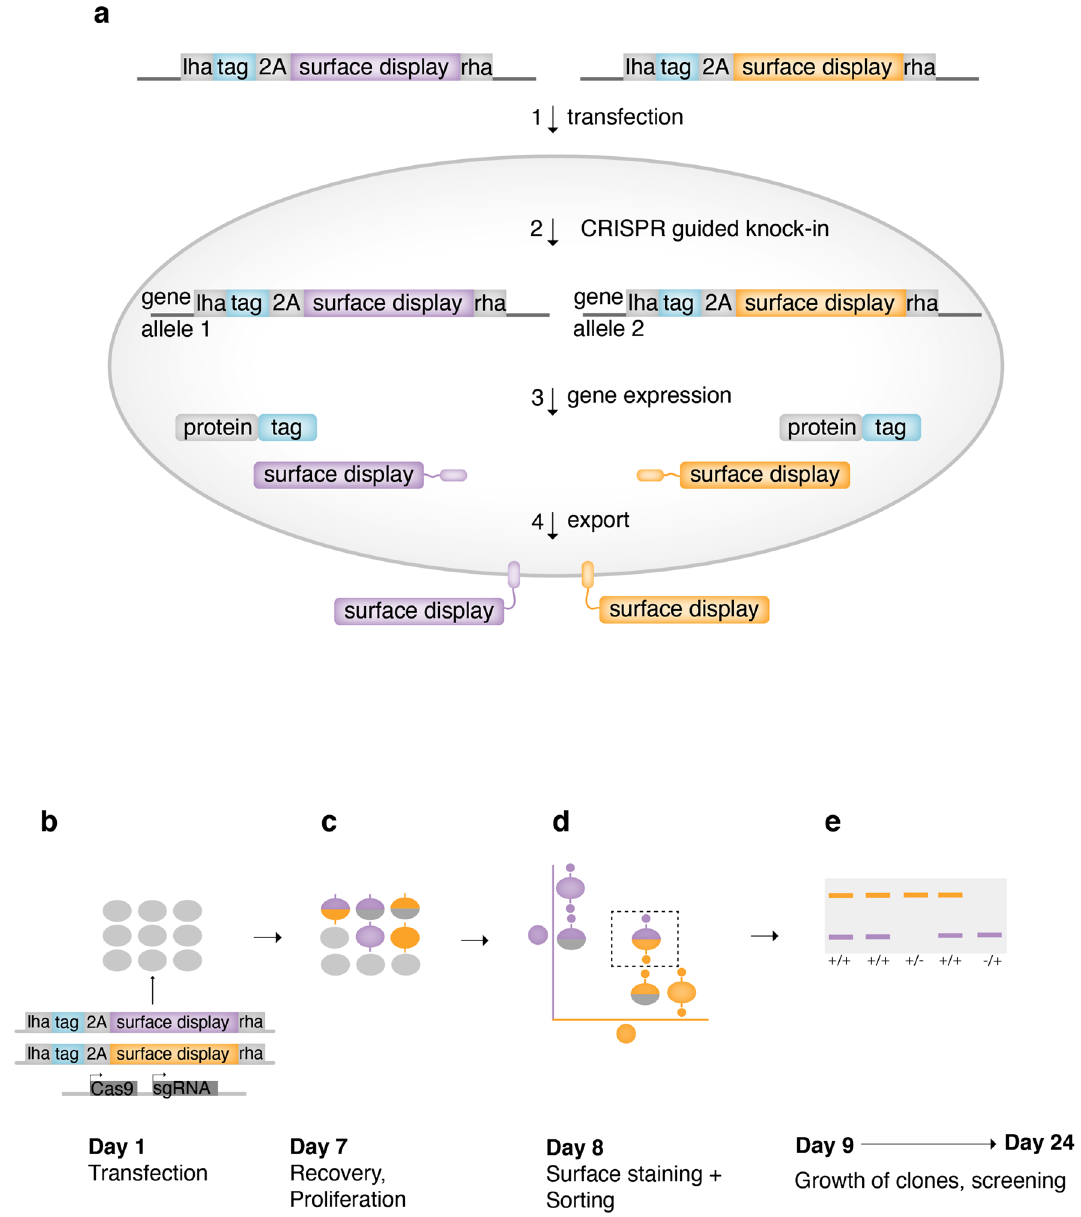
Figure 1. Selecting biallelic CRISPR knock-ins using SNEAK PEEC ( a ) Transfection of a cell with two repair templates and Cas9 and guide RNA enables knock-in at the 3’ end of both alleles of a target gene. Each repair template encodes an identical tag (blue), 2A self-cleaving peptide (grey) and unique cell-surface display (purple or yellow). Biallelically edited cells in which each allele has been targeted using a different repair template express the tagged protein as well as both unique cell-surface displays. Upon expression, each surface display is exported to the cell surface and displayed extracellularly. The 2A self-cleaving peptide ensures bicistronic expression of the tagged target protein and surface display (lha and rha; left and right homology arms). ( b ) Timeline for SNEAK PEEC. Transfection (Day 1) followed by cell recovery and proliferation (Day 7). Cells are surface stained and sorted for single cell clones expressing both surface displays (Day 8). Clones are expanded (Days 9–23), followed by PCR screening to confirm the genomic integration of both repair templates (Day 24), and hence biallelic